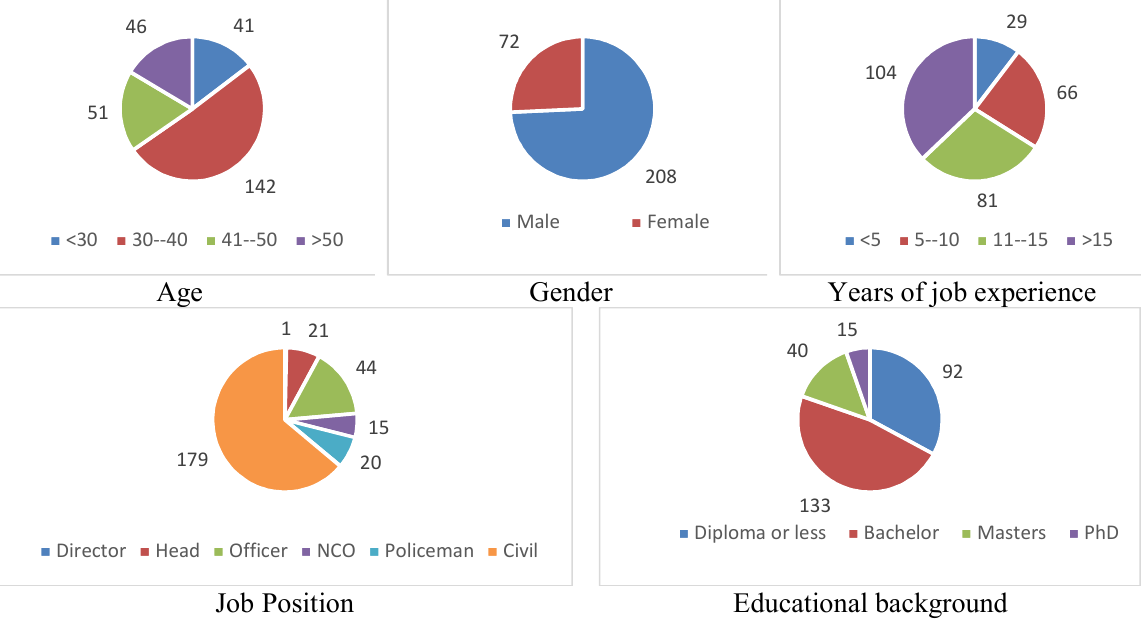
The arithmetic mean, standard deviations, rank and relative importance of the variables Type of variable Variables Average Standard Independent